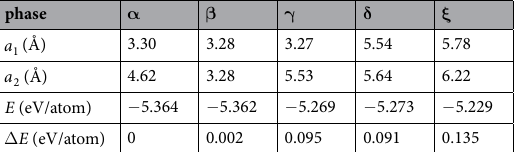
Table 1. The optimized lattice constants ( a 1 , a 2 ), total energy ( E ), and energy relative to the α -phase ( Δ E ) of the five phosphorene allotropes.